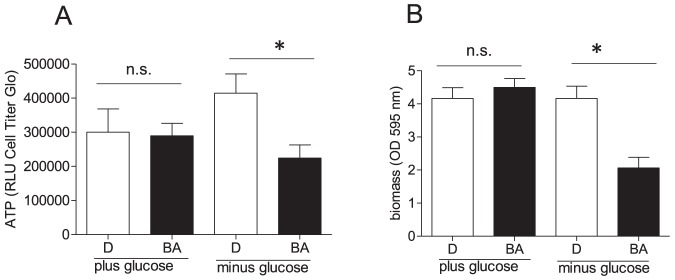
Glucose-addiction in the presence of BA.MEF were treated with DMSO (0.1%, D) or BA (10 µM) in DMEM (containing 1% serum, glutamine (2 mM) and pyruvate (2 mM)) in the presence (25 mM) and absence of glucose (instead 25 mM mannitol as osmotic balance) for 48 h before ATP levels (A) and biomass (B) were assessed. Bar graphs depict compiled data of three experiments in quadruplicate. (mean + SD, * p<0.05, t-test DMSO vs BA).